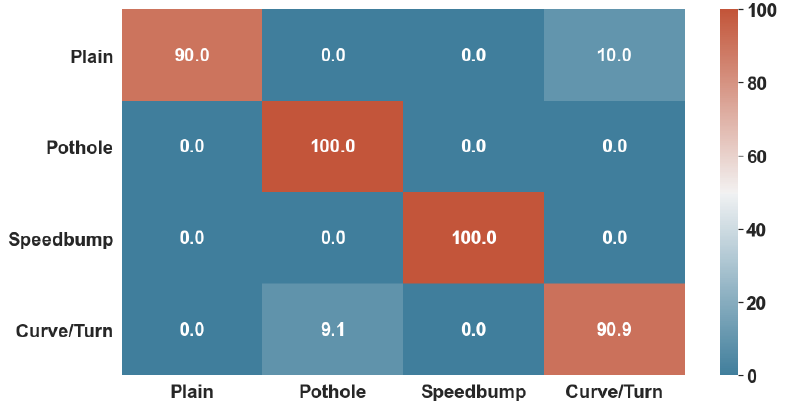
Figure 10. KNN Confusion Matrix over Test Data.